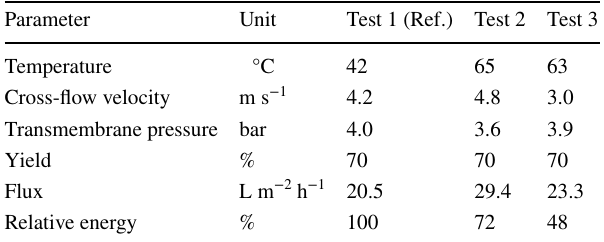
Relative energy %